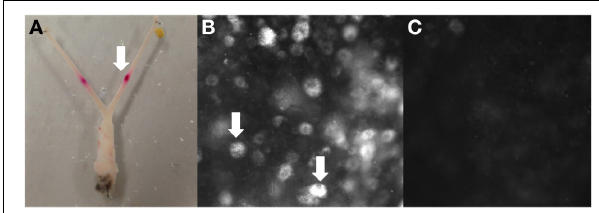
FIGURE 1 | Example of retrograde tracing observed in DRG after DiI injection into the uterus in vivo . (A) Site of bilateral DiI injections into each uterine horn, (B) DiI labeled neurons (indicated by arrows (L2) and (C) no labeling